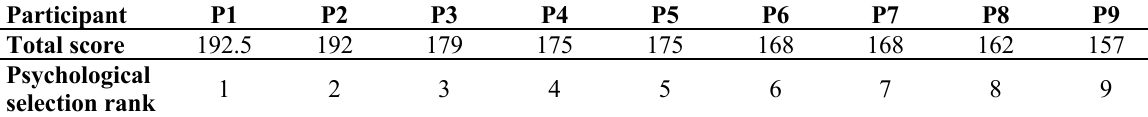
Ranking of all cadets for the psychological selection test.